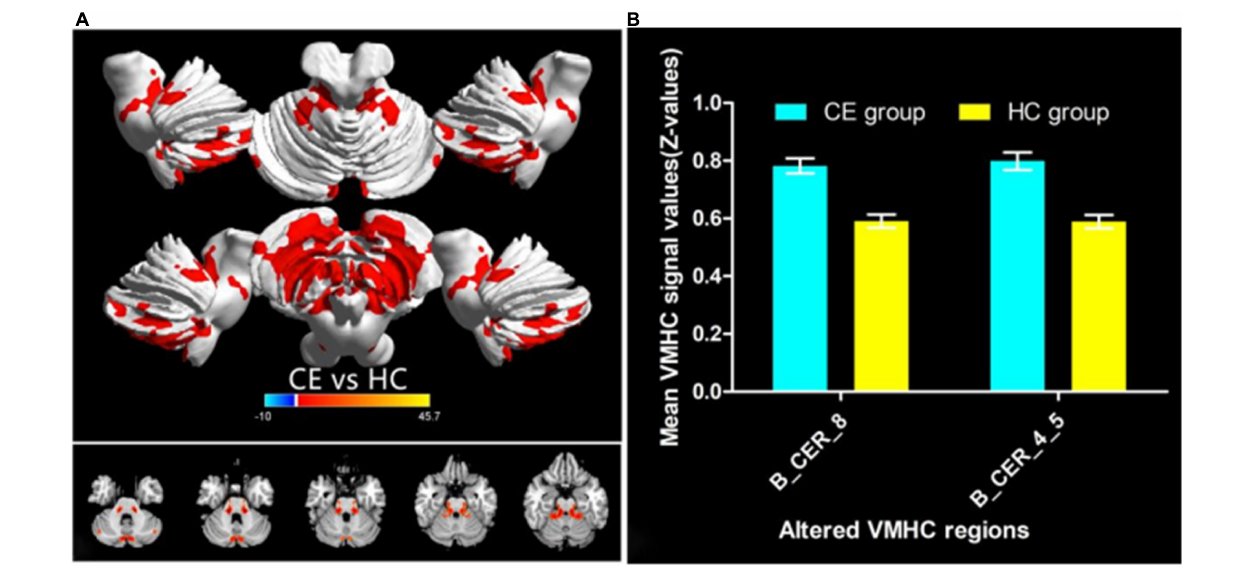
Frontiers in Human Neuroscience |